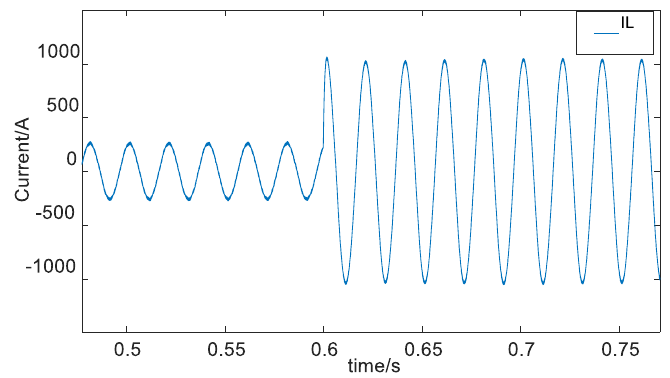
Figure 22. The output current of MMC-RPC.